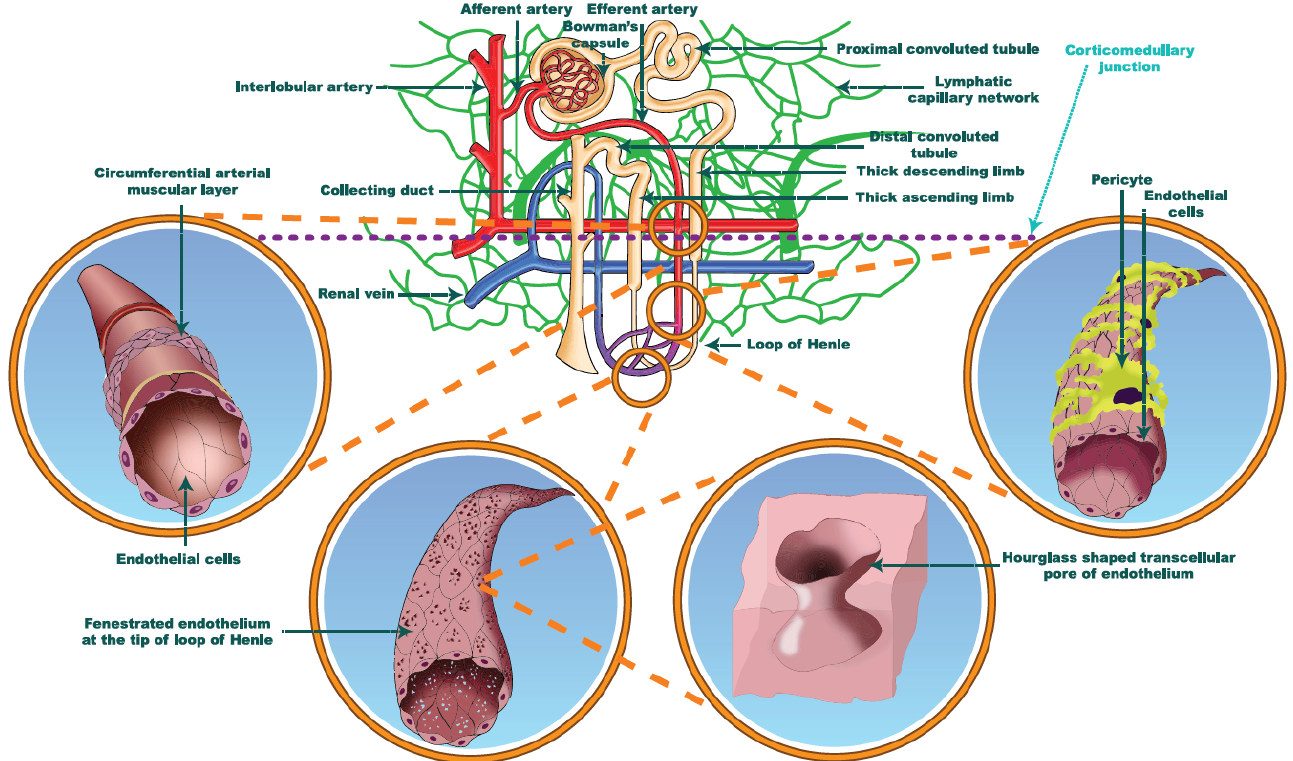
Figure 2. The microscopic anatomy of the arterial wall and the endothelium of vasa recta along their course towards the tip of medulla. Red vessels: arteries; blue vessels: veins; purple vessels: connection vessels between arteries and veins; yellow tubes: urine conducting system; green vessels: lymphatic network.